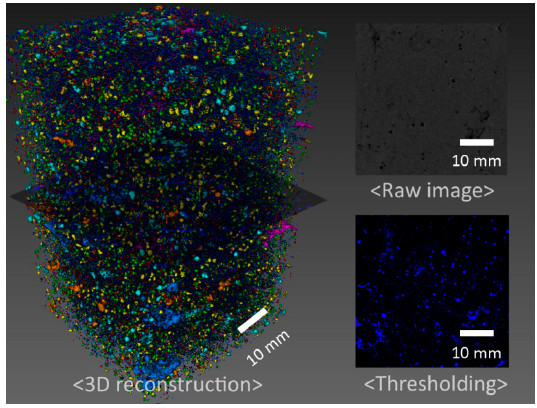
Figure 1. 3D pore-structure reconstruction of 1.8% TA 200 °C sample from image-analysis technique.